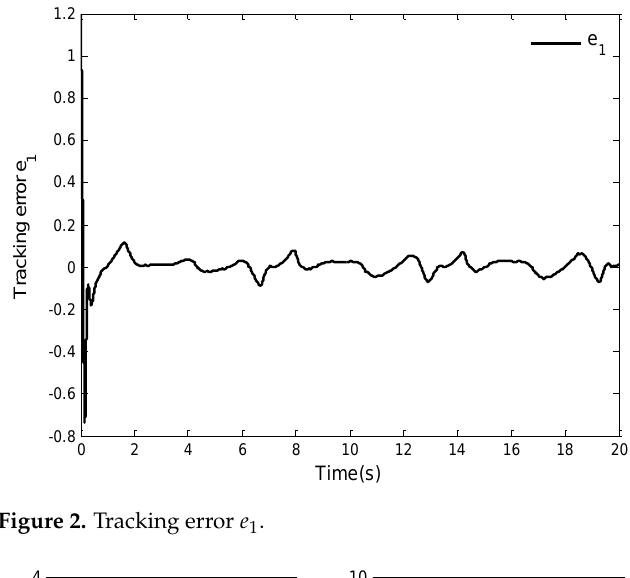
Figure 2. Tracking error e 1 .